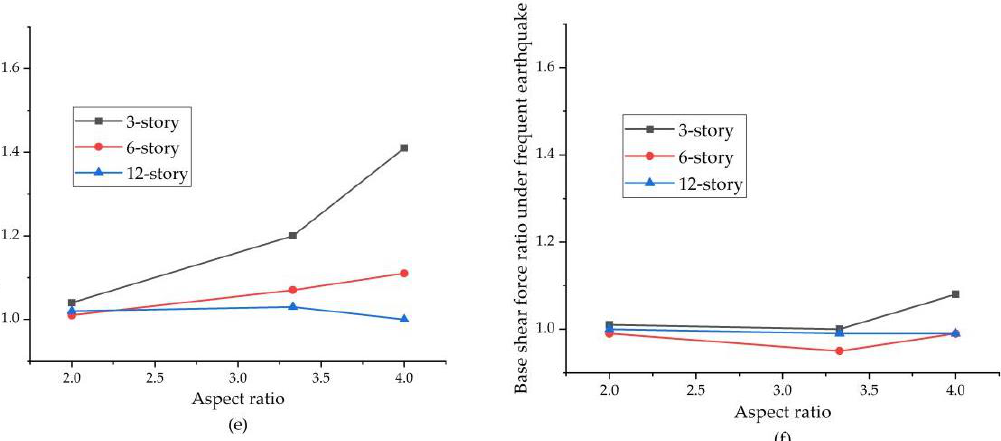
Figure 10. The effect of flexible diaphragm on seismic performance: ( a ) fundamental period ratio; ( b ) elastic top displacement ratio under frequent earthquakes; ( c ) inelastic top displacement ratio under rare earthquakes; ( d ) elastic maximum inter-story drift ratio under frequent earthquake; ( e ) inelastic maximum inter-story drift ratio under rare earthquake; ( f ) base shear force ratio under frequent earthquake.